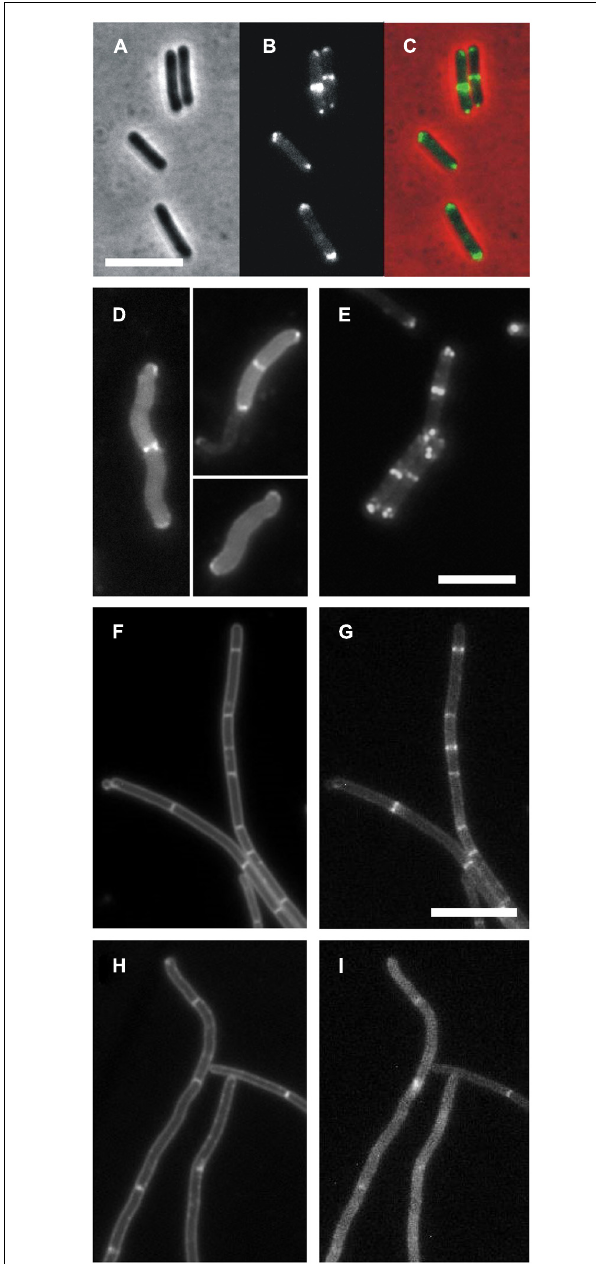
FIGURE 2 | DivIVA-GFP localization is disturbed in a secA12 and secA341 mutant strains. (A–C) Localization of DivIVA-GFP in wild type B. subtilis . Cells of strain 1803 were analyzed by phase contrast (A) , and fluorescence microscopy (B) . A merged image is shown in C . (D) Fluorescence micrograph showing the localization of DivIVA-GFP in a strain expressing the SecA12 mutant protein (BSN164, grown without IPTG). (E) Same strain with 1 mM IPTG using identical exposure times. (F–I) Delocalization of DivIVA-GFP in the secA341 mutant. An ectopic version of DivIVA-GFP was induced in BSN67 cells containing the temperature sensitive secA341 mutation and analyzed by fluorescence microscopy during growth at 30 ◦ C (G) , and at 37 ◦ C (I) . Nile red stained images are presented in the left panels (F,H) . Scale bars are 5 μ m for all images. Note that DivIVA-GFP only partially complements the (cid:3) divIVA phenotype, explaining filamentation of BSN67